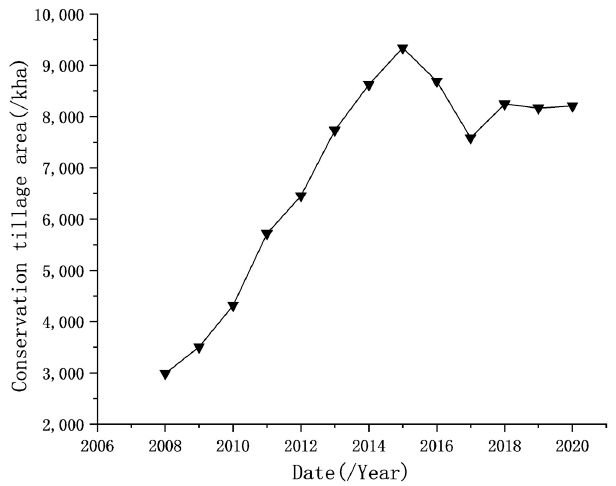
Figure 2. Area Under Conservation Tillage in China